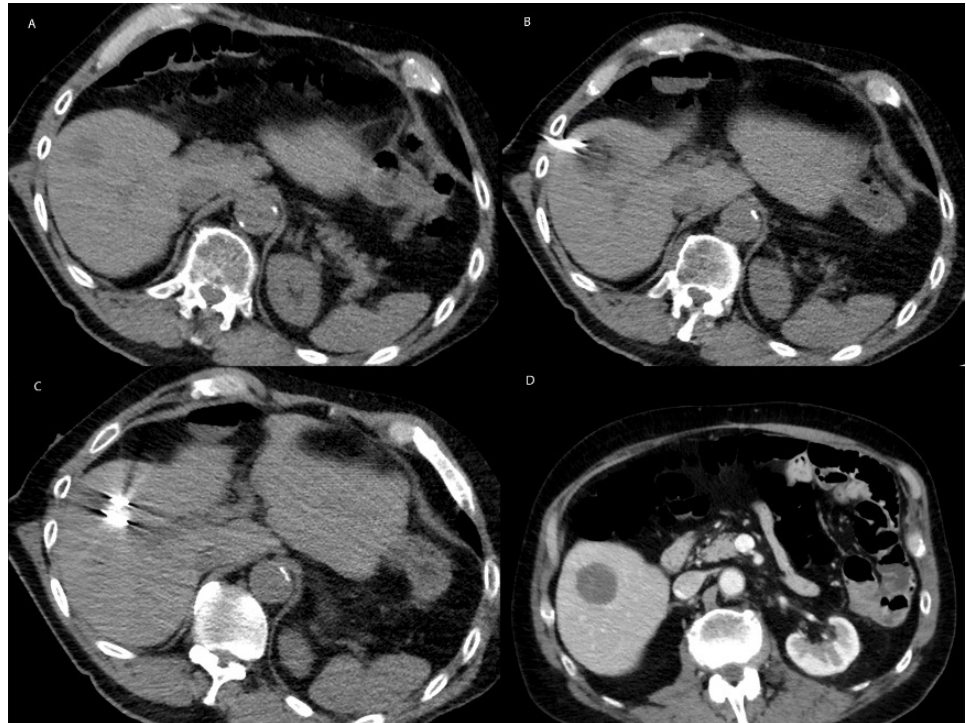
Figure 2. Representative image of MWA. ( A )Noncontrast enhanced preprocedural axial CT demon- strating a well circumscribed hypoattenuating lesion in segment 5 concerning for metastasis in a 74-year-old male with rectal carcinoma. ( B ) The lesion was ablated by application of 100 watts for 7 minutes through each of the adjacent probes. The ablation zone is visualized as a region of hypo attenuation along the antennae. ( C ) Under CT guidance, two Neurowave microwave antenna are positioned within the lesion to provide overlapping ablation zones. ( D ) Contrast enhanced axial CT demonstrating a hypoattenuating lesion overlying the previous ablation zone.